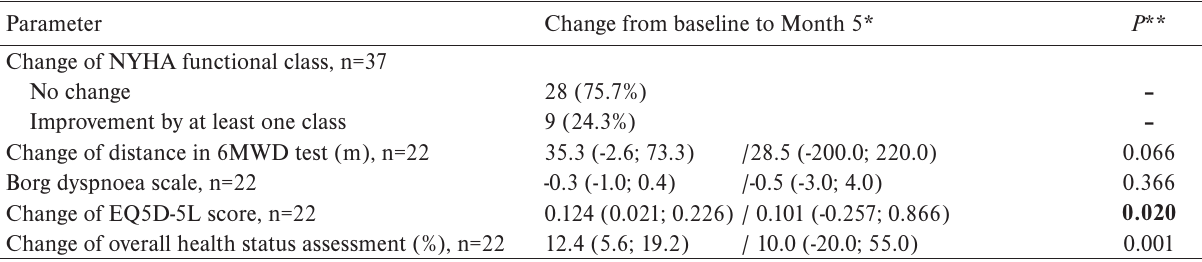
Table 2. Change in endpoints from baseline to 5 months (mean 5.0 months; median 5.3 months) of riociguat